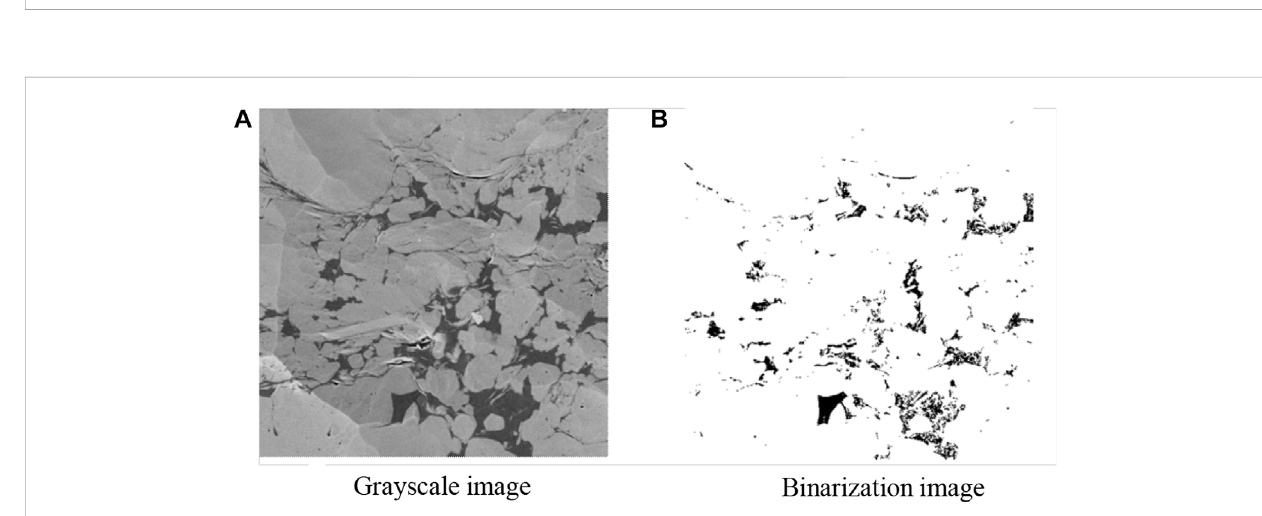
FIGURE 2 Grayscale image (A) and binarization image (B) of deep shale core in Luzhou block fl ow.